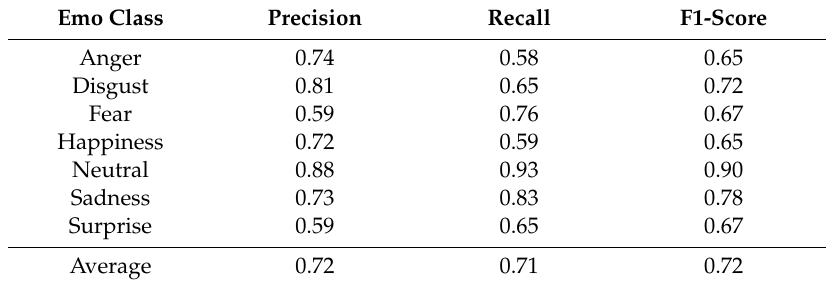
Table 6. Cross-corpus emotion recognition result using proposed fine-tuning method on